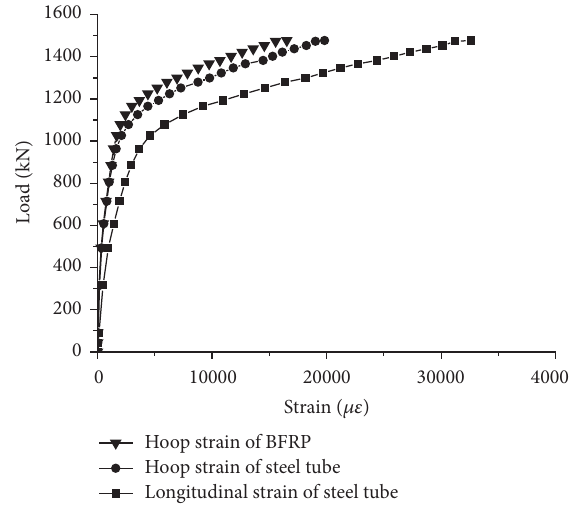
Figure 7: Load-strain curves of BCFST-1. Table 3: Comparisons of axial compressive capacity from experi- ment and analytical results.